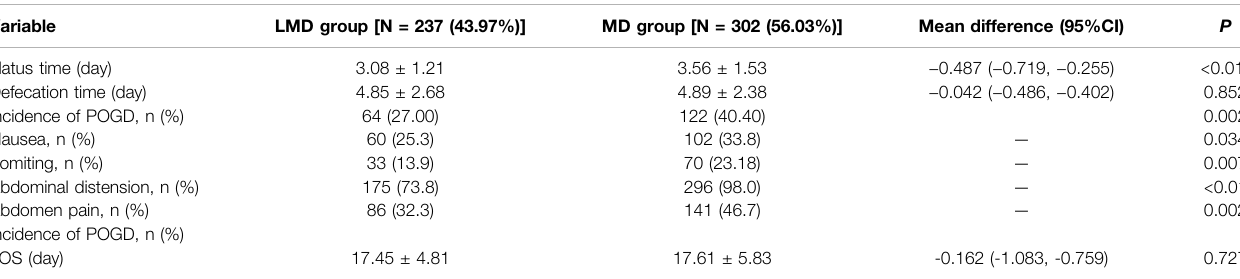
TABLE 3 | Patient recovery